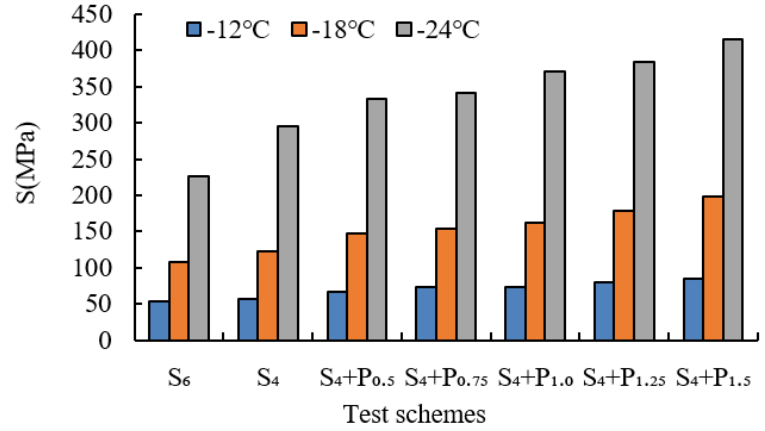
Figure 9. Creep stiffness of PPA – SBS and DH – 70# asphalt.